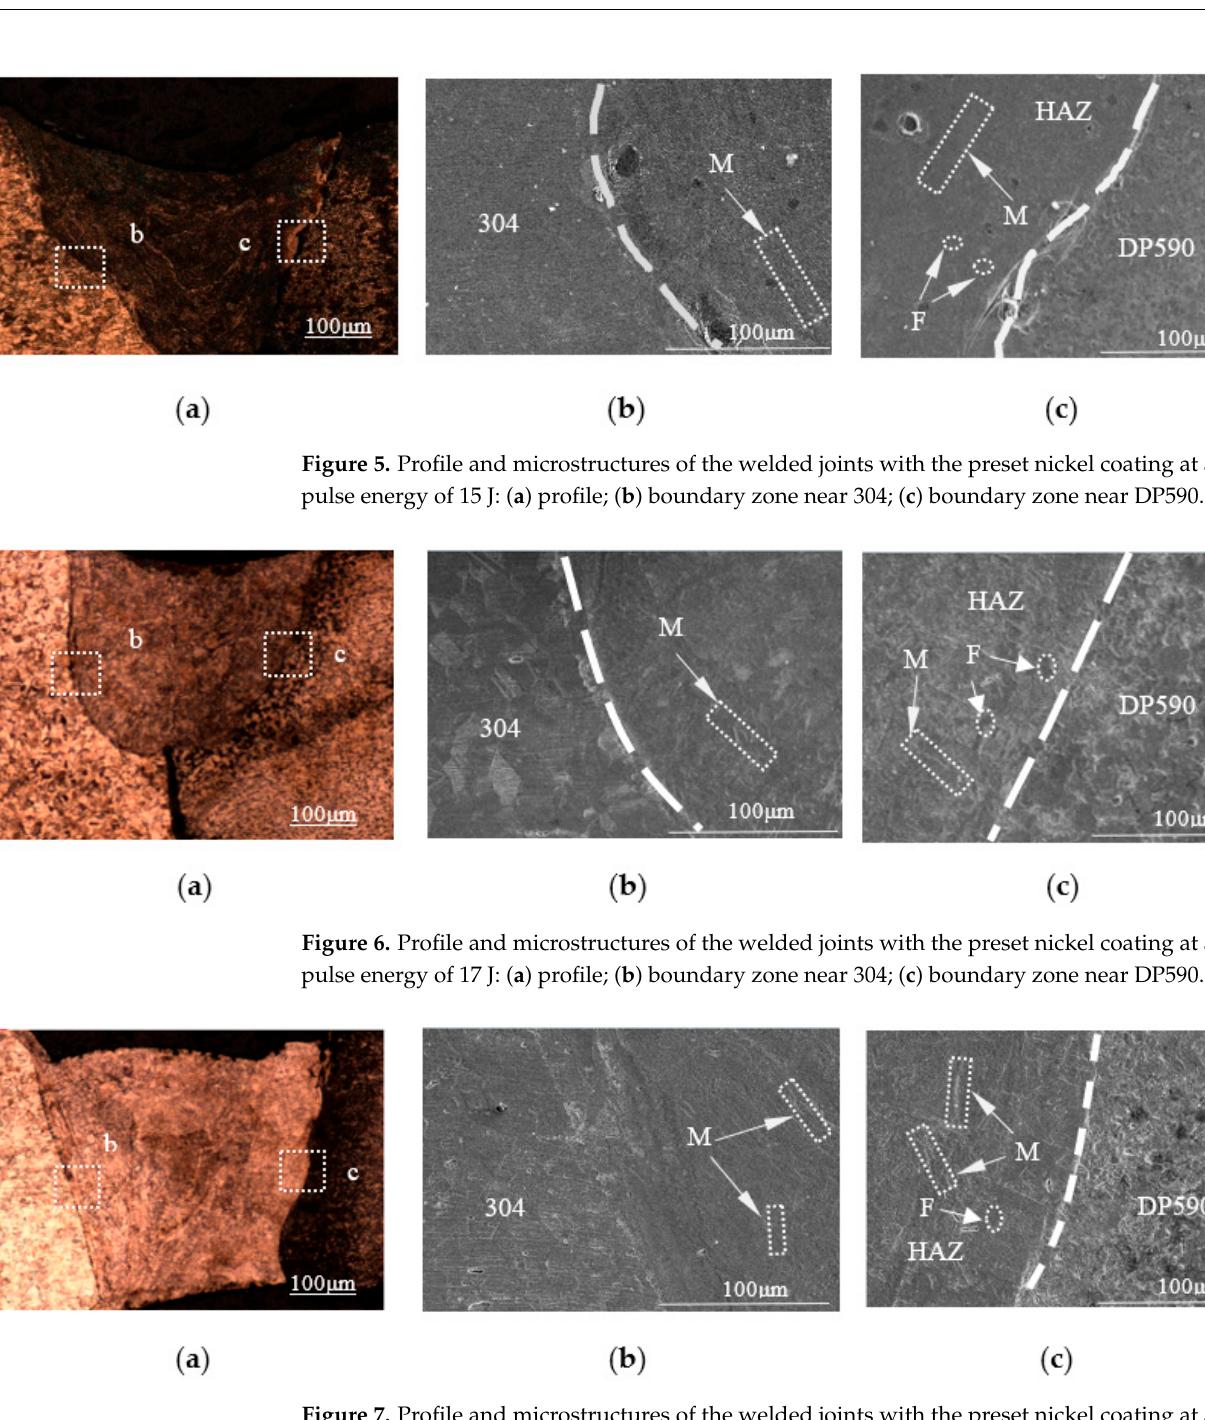
Figure 7. Pro fi le and microstructures of the welded joints with the preset nickel coating at a single- pulse energy of 19 J: ( a ) profile; ( b ) boundary zone near 304; ( c ) boundary zone near DP590.